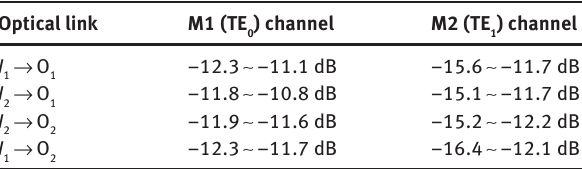
Table 1: The insertion losses of different optical links for two mode